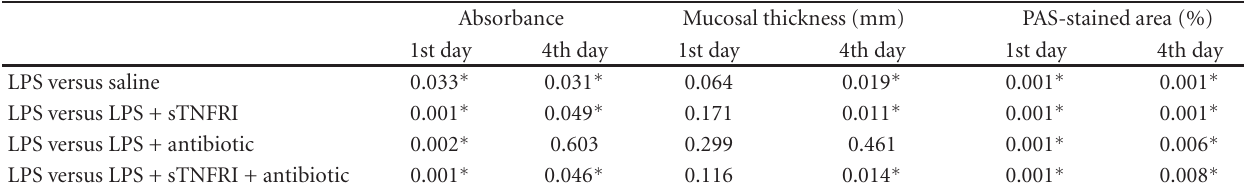
Table 3: Significance of di ff erences ( P value) in histopathological variables between the LPS and other groups.